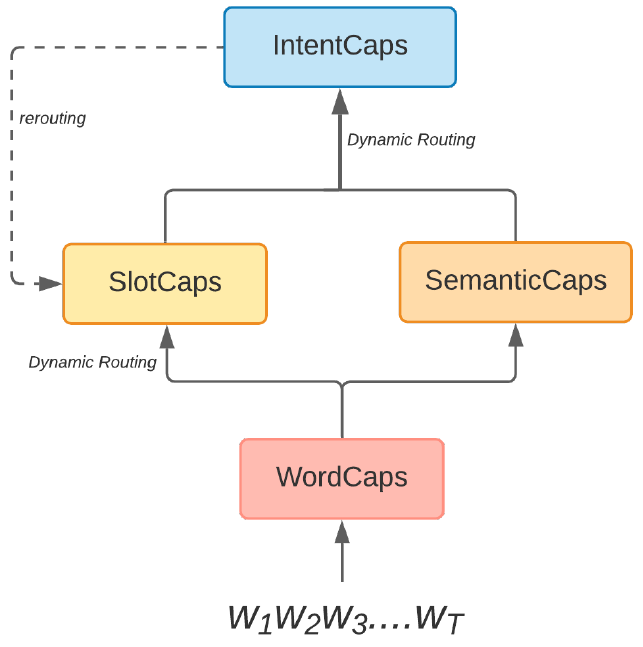
Figure 3. S EM C APS N ET